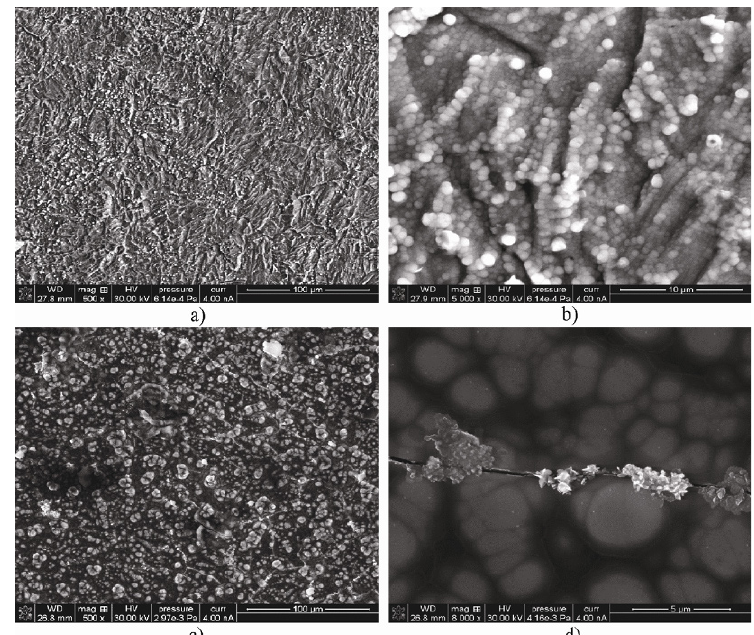
Figure 5. SEM images of: a-b) ZNP(1); c-d) ZNP(2).